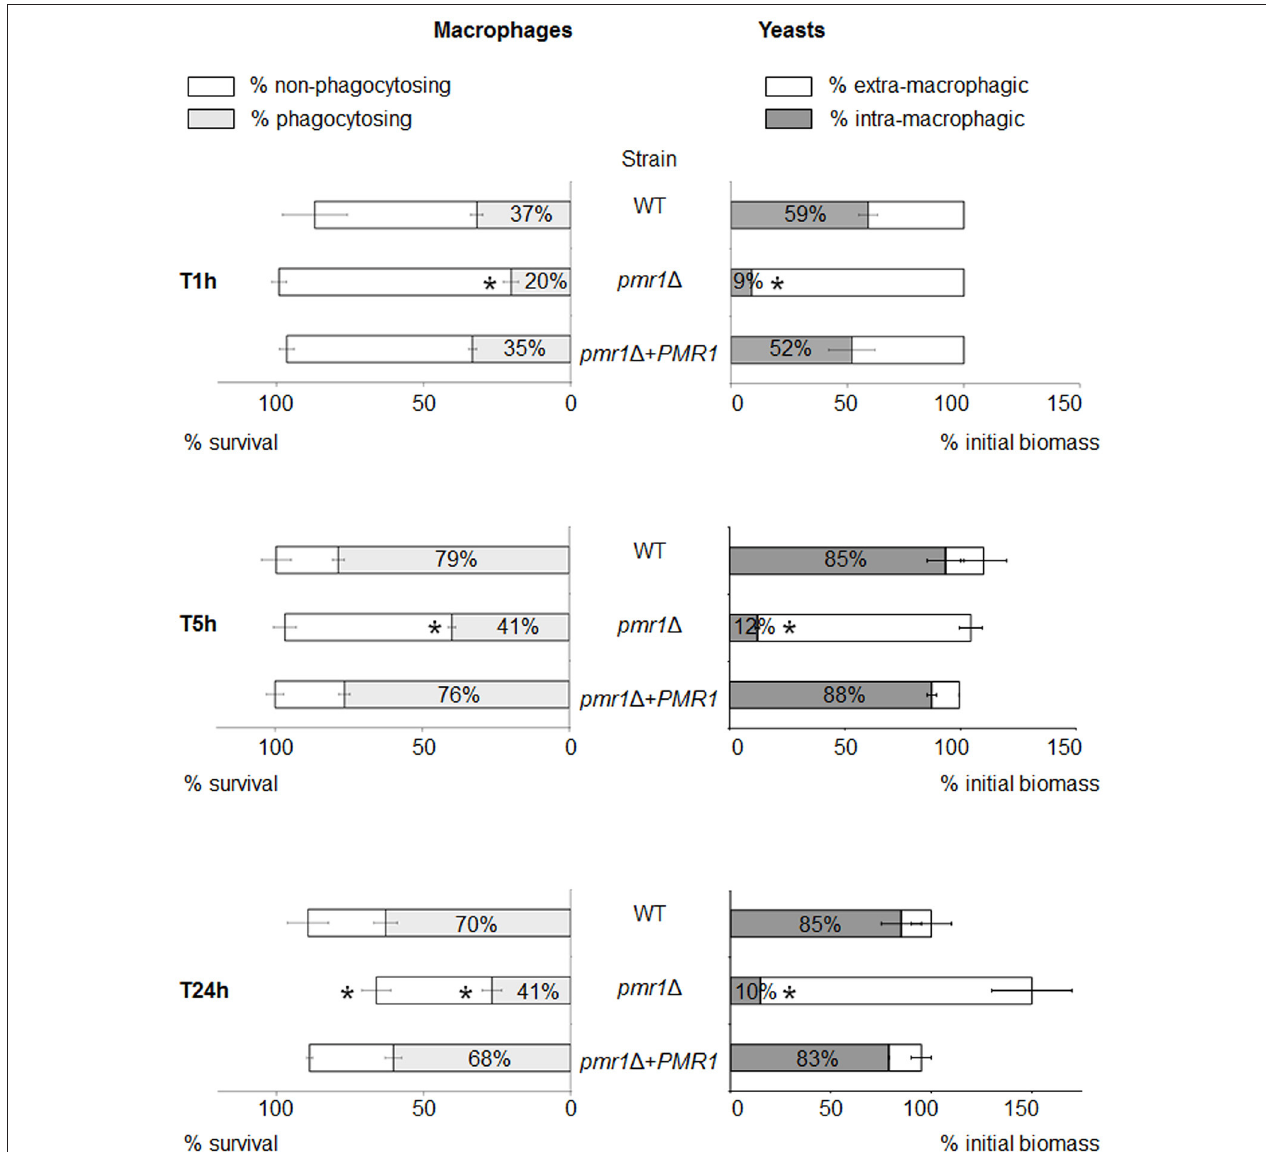
FIGURE 9 | Multi-parametric analysis of murine macrophage interaction with C. guilliermondii cells over 24-h time course experiments. Macrophages were infected with the parental (KU141), the pmr1 1 null mutant or the re-integrant ( pmr1 1 + PMR1 ) strain as described in Materials and Methods. The diagram shows the flow cytometer analysis of the infected macrophages on the left part. The macrophage survival is indicated by the horizontal bar. The white part of the bar represents the percentage of non-phagocytosing macrophages; the gray part represents the percentage of macrophages engaged in phagocytosis. The right part of the diagram shows the fluorometry analysis of the fungal population. The horizontal bar represents the multiplication of the yeast cells in the presence of macrophages, expressed as a percentage of the initial biomass at T1h. The white part of the bar shows the percentage of extra-macrophagic yeasts, the gray part shows the percentage of yeast cells internalized within the macrophages. Each condition was performed in quintuplet (flow cytometry experiments) or in triplicate (fluorescence quenching experiments) per experiment. Each bar is the average of three independent experiments ± standard error. Unpaired T -test was used to establish statistical significance. * P <